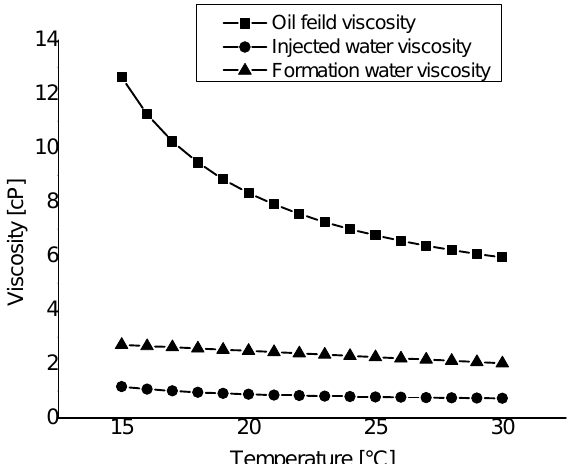
Figure 3. Viscosity evolution versus the temperature for the fluids used in the water/oil relative permeability